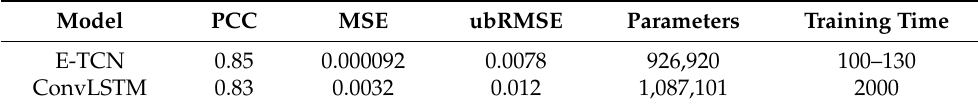
Table 4. Error metrics, number of trainable parameters and training time (msec per step) for the dataset consisted of images of 60 × 60 pixels with 1 km per pixel obtained from a region in